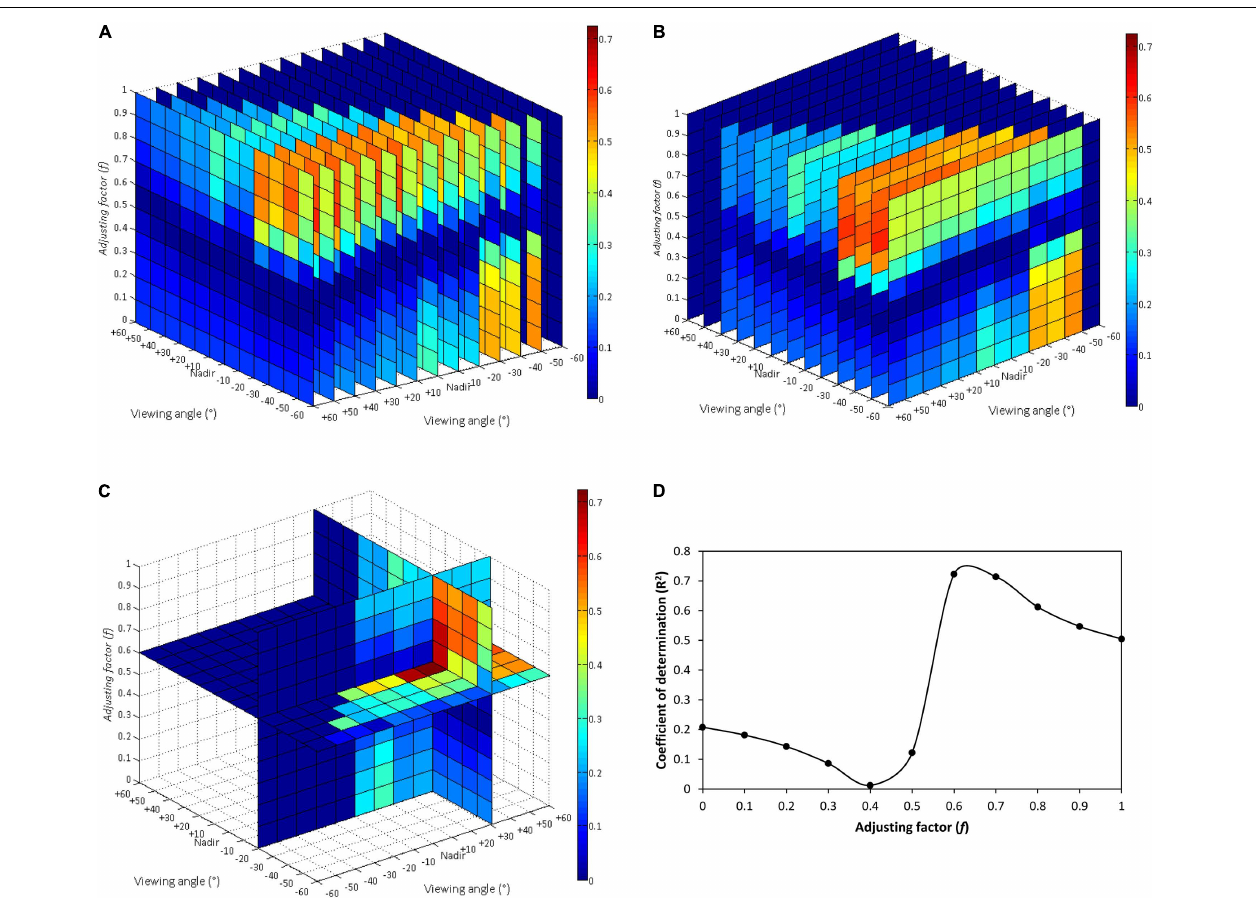
FIGURE 8 | The three-dimensional slice maps of the R 2 for relationship between field measured canopy chlorophyll content and BCVI MCARI [ 705 , 750 ] calculated by the subtraction of MCARI[705,750] at all the possible two-angle observations selected from 13 viewing angles between –60 ◦ and +60 ◦ , in which an adjusting factor f varied from 0 to 1 at a step of 0.1: (A) slice map for the first viewing angle ( θ 1) selection, (B) slice map for the second viewing angle ( θ 2) selection, (C) slice map for optimum two-angle and f value combination; (D) changing curve of R 2 for relationship between field measured canopy chlorophyll content and BCVI MCARI [ 705 , 750 ] at +30 ◦ and –20 ◦ angle combination along with variety of f values.